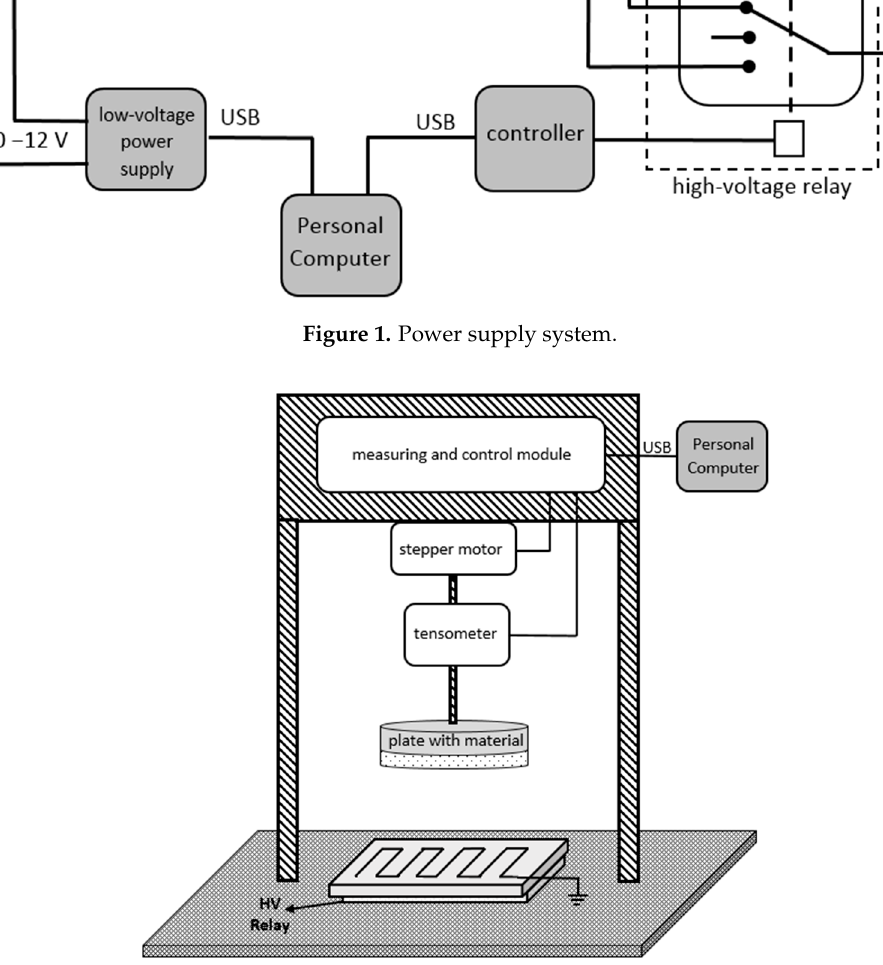
Figure 1. Power supply system.